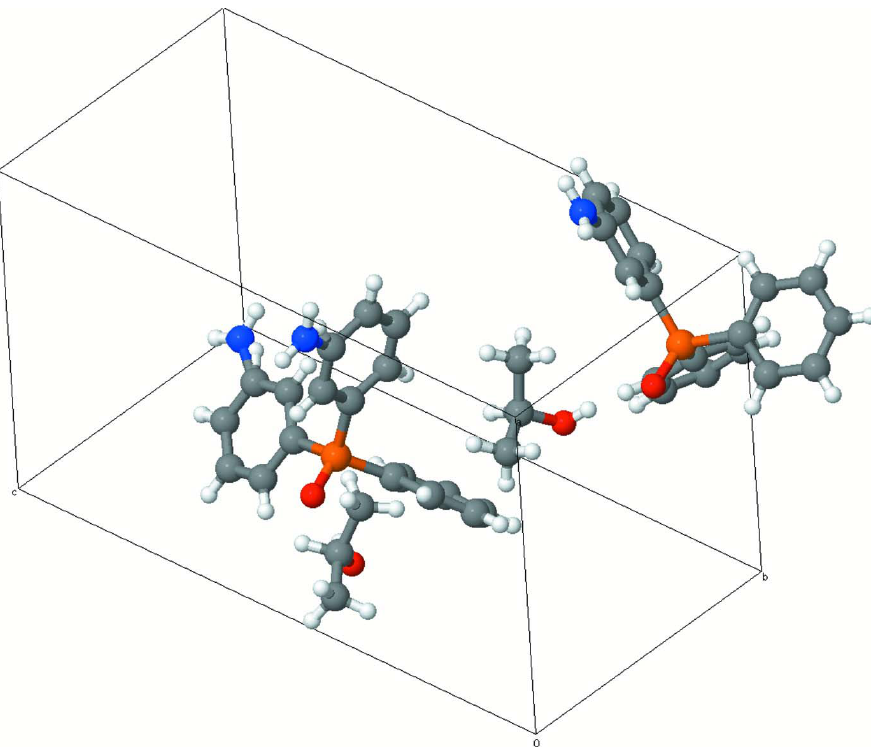
Figure 6 An interactive view of the asymmetric unit of the title compound including the disorder in the amino group position in the second